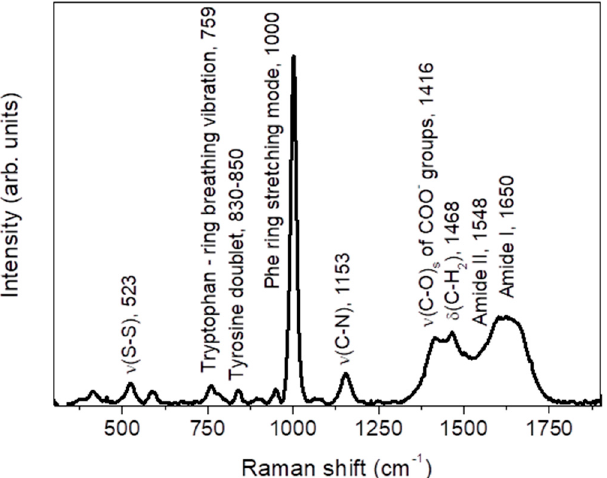
Figure 1. Average Raman spectrum of non-IBD subjects, together with the main vibrational assignment. See text for details.